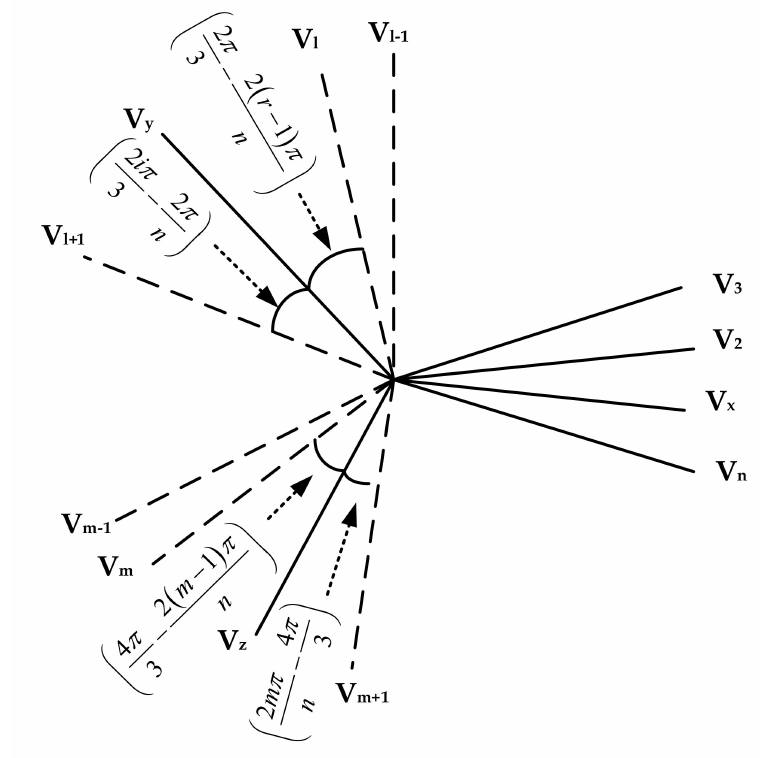
Figure 4. Phasor diagram of an n -phase